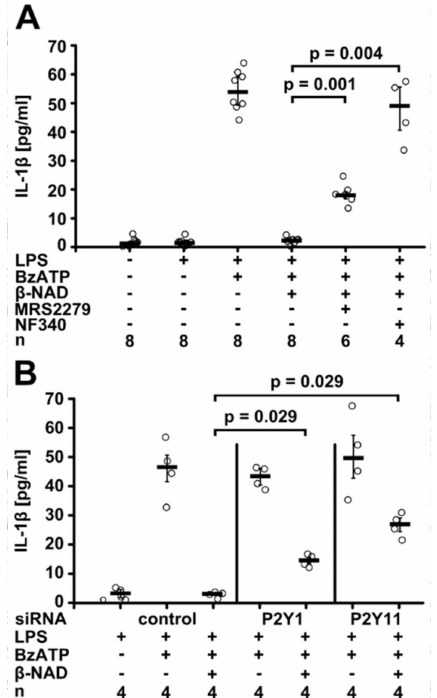
Figure 3. β -NAD signals via P2Y receptors. Human monocytic U937 cells were primed with LPS (1 µ g/mL, 5 h) and stimulated with 2 (cid:48) (3 (cid:48) )- O -(4-benzoylbenzoyl)adenosine-5 (cid:48) -triphosphate (BzATP; 100 µ M, 30 min). β -NAD was applied together with BzATP at a concentration of 1 mM. The concentration of IL-1 β in the cell culture supernatant was measured by ELISA. ( A ) Experiments were performed in the presence or absence of the P2Y1 receptor antagonist MRS2279 (500 nM) or of the P2Y11 receptor antagonist NF340 (5 µ M); ( B ) U937 cells were transfected with control siRNA or with siRNA targeting P2Y1 or P2Y11 ( P2RY1 , P2RY11 ). Data are presented as individual data points, bars indicate median, whiskers encompass the 25th to 75th percentile, Kruskal-Wallis test followed by the Mann-Whitney rank sum